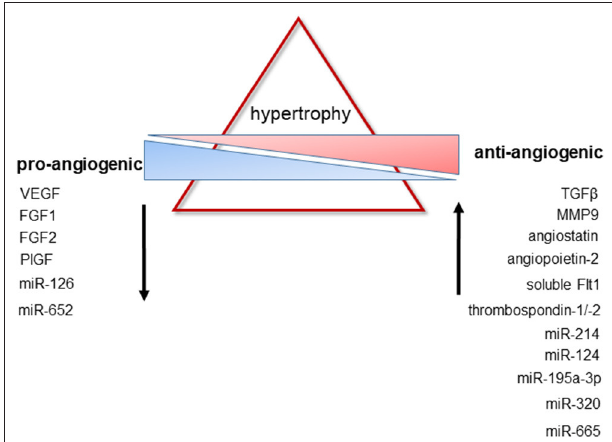
FIGURE 2 | Changes in pro- and anti-antiangiogenic factors during cardiac hypertrophy. Pathological hypertrophy is associated with a decreased expression of factors known to promote new vessel formation, whereas the expression of factors with anti-angiogenic properties is upregulated. For further details and additional regulatory mechanisms, please see the